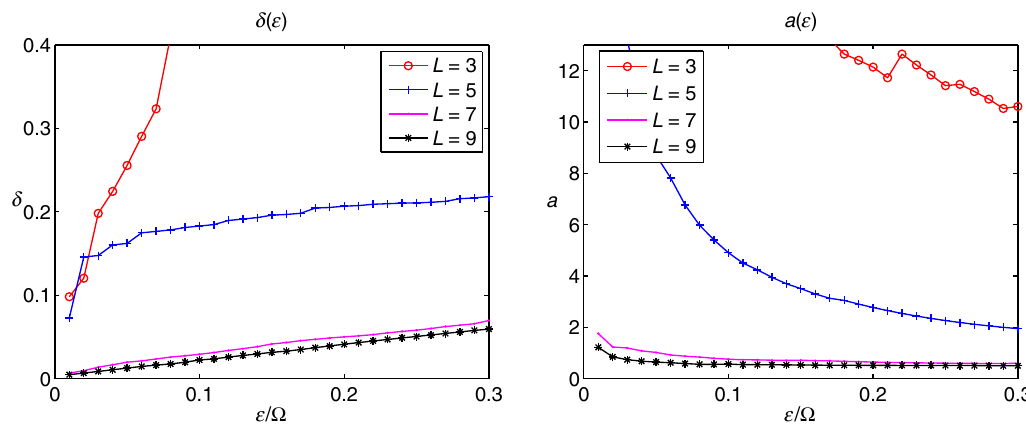
σ x ⊗ ⨂ L 1 λ and initial state 1 λ ¼ 2 x ¼